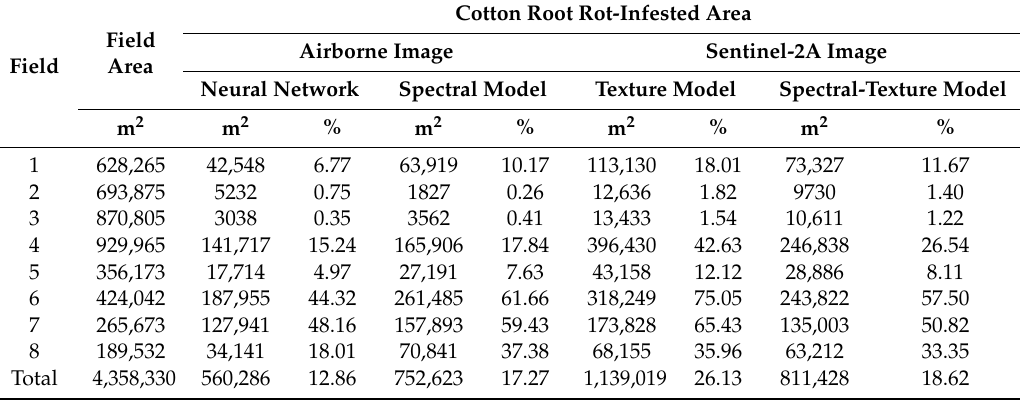
Table 5. Cotton root rot-infested areas of classification maps generated from airborne images and Sentinel-2A images for Fields